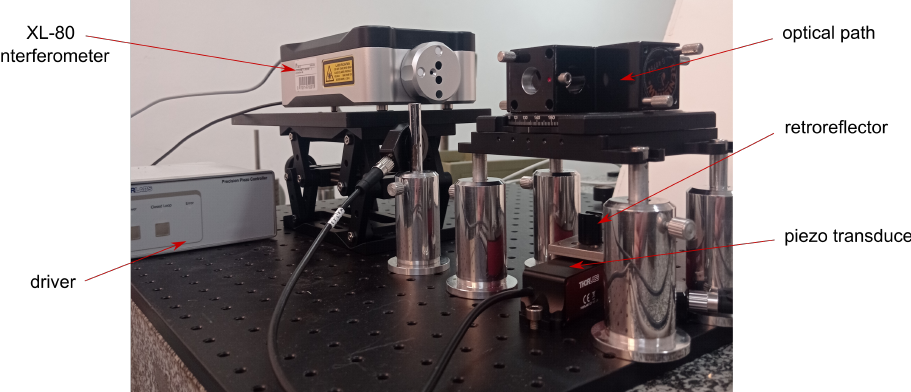
Figure 3. LPS710M (Thorlabs) piezo actuator during calibration with the XL-80 interferometer system (Renishaw). The acquisition was made with Laser XL system’s software (Renishaw), dynamic linear option.